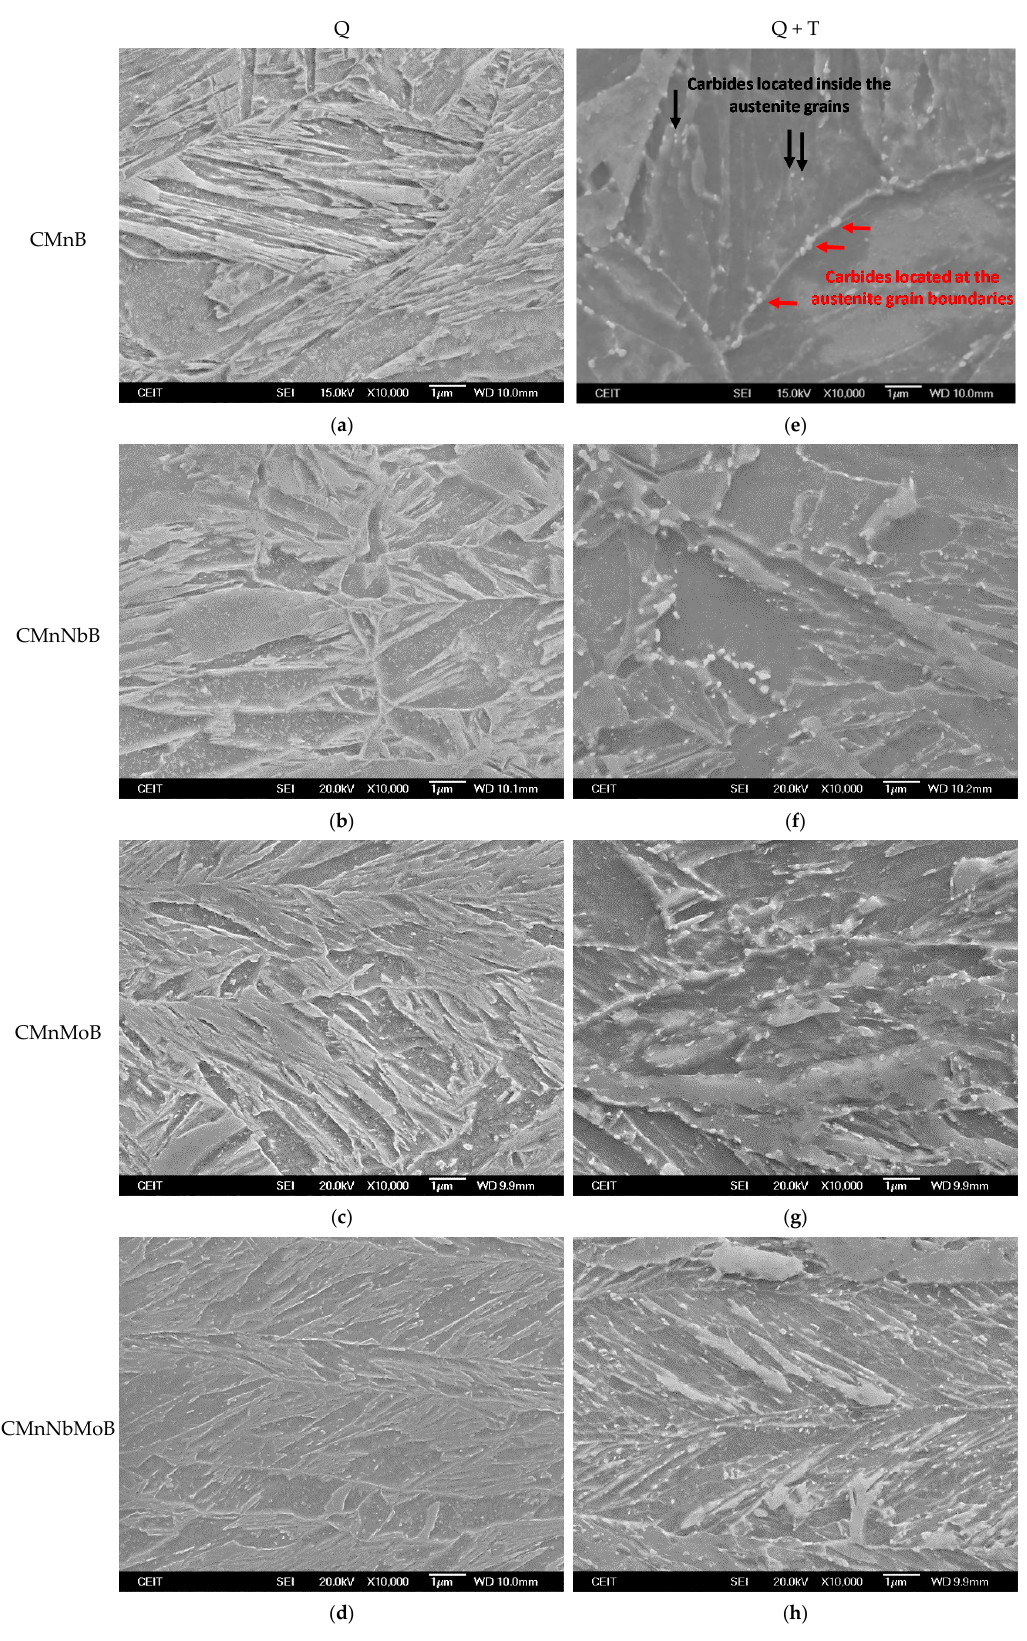
Figure 3. FEGSEM micrographs corresponding to ( a – d ) Q and ( e – h ) Q + T conditions for ( a , e ) CMnB, ( b , f ) CMnNbB, ( c , g ) CMnMoB steel, and ( d , h ) CMnNbMoB steels.